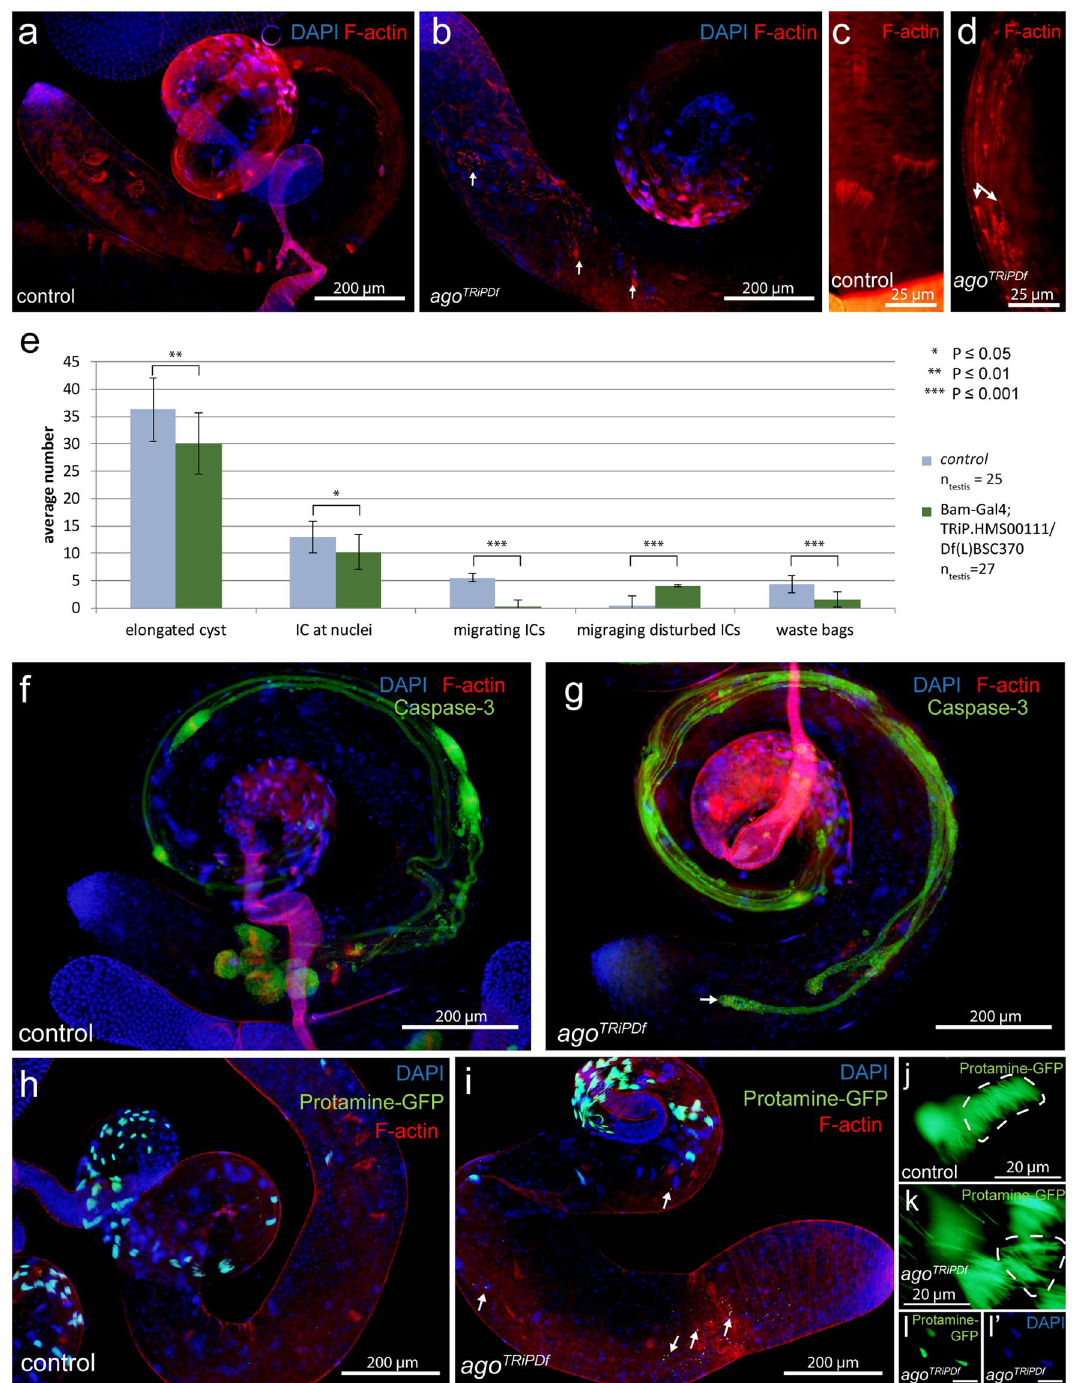
Figure 2. Individualization defects in ago TRiPDf testes and Protamine-GFP (green) accumulation in ago TRiPDf spermatids. ( a-d ) Investment cones visualized by fluorescent microscopy using Texas Red-X phalloidin staining (red) and nuclei with DAPI in control ( a , c ) and ago TRiPDf testes ( b , d ). Scattered investment cones with variable size are present in the ago TRiPDf cysts ( b , d arrows). ( e ) The average number of individualization complexes (ICs) in control and ago TRiPDf testis. Error bars indicate mean ± s.e.m. Statistical significance was determined by Welch two-sample t-test. ( f-g ) Anti-cleaved Caspase 3 (green) highlight the caspase activity in the control and ago TRiPDf cysts. Morphologically normal cystic bulges and waste bags are present and cleaved Caspase3 accumulates in control testes ( f ). In ago TRiPDf testes ( g ), the cystic bulges and waste bags are severely damaged. ( h–l’ ) Nuclei are visualized with Protamine-GFP (green) and DAPI (blue), F-actin with Phalloidin-Texas Red (red). Nuclear bundles are slightly disoriented in ago TRiPDf cyst compared to wild type ( h,j , i,k ). DAPI and Protamine-GFP positive hypercondensed nuclei are present in ago TRiPDf testes ( i arrows, l,l’ ). The chart was created in Microsoft Excel 2016 MSO ver. 16.0.4266.1001 and processed in Adobe Illustrator CS6